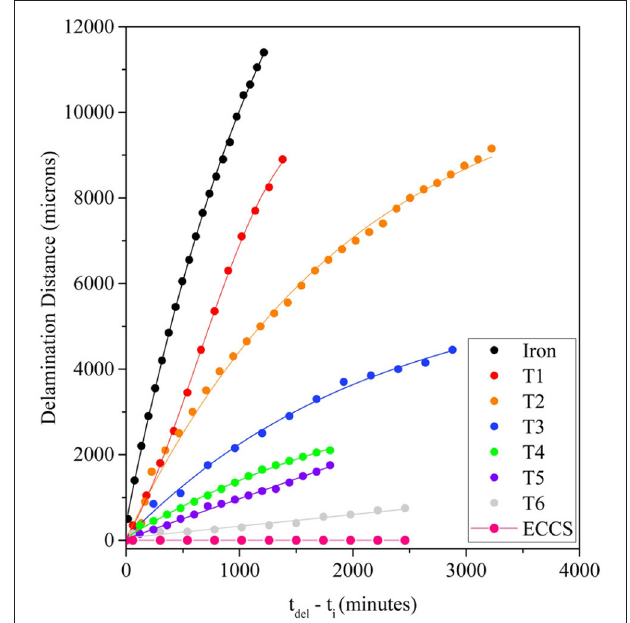
FIGURE 13 | Delamination distance vs. time of delamination of polyvinyl butyral coating on chrome-chrome oxide Cr(III)—steel substrate as function of formulation of conversion coating ( Edy et al.,